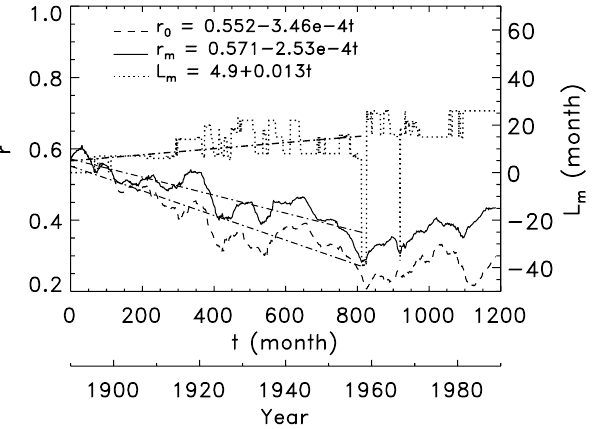
Fig. 5. Similar to Fig. 2 using the uncorrected aa series.